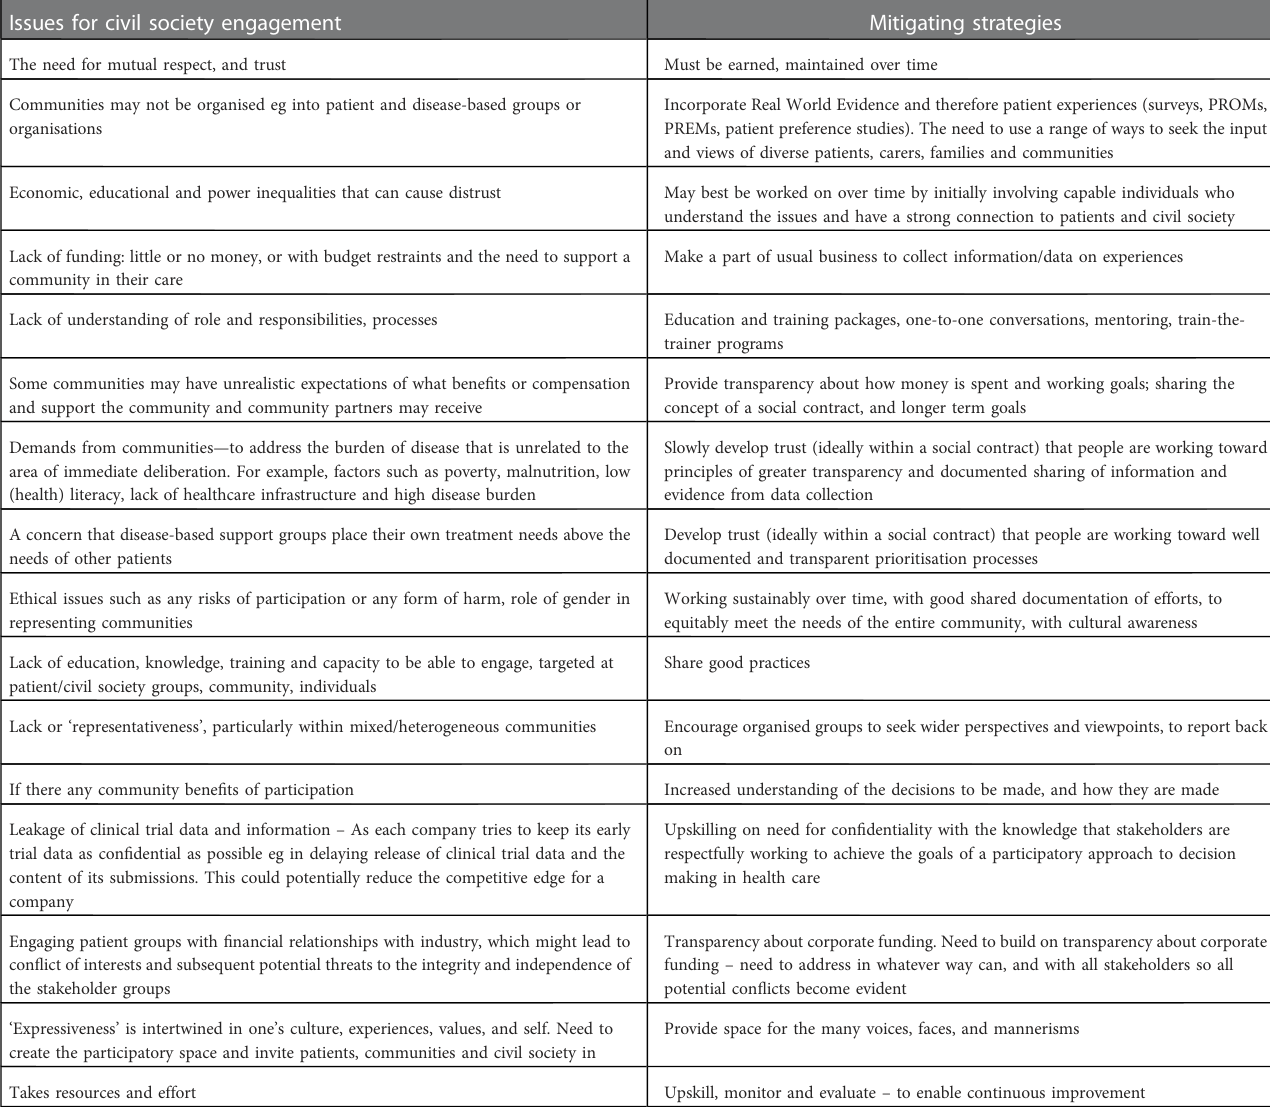
TABLE 1 Collated identi fi ed issues for meaningful civil society engagement with multi-stakeholders, and possible mitigating strategies, based on the literature and experiential